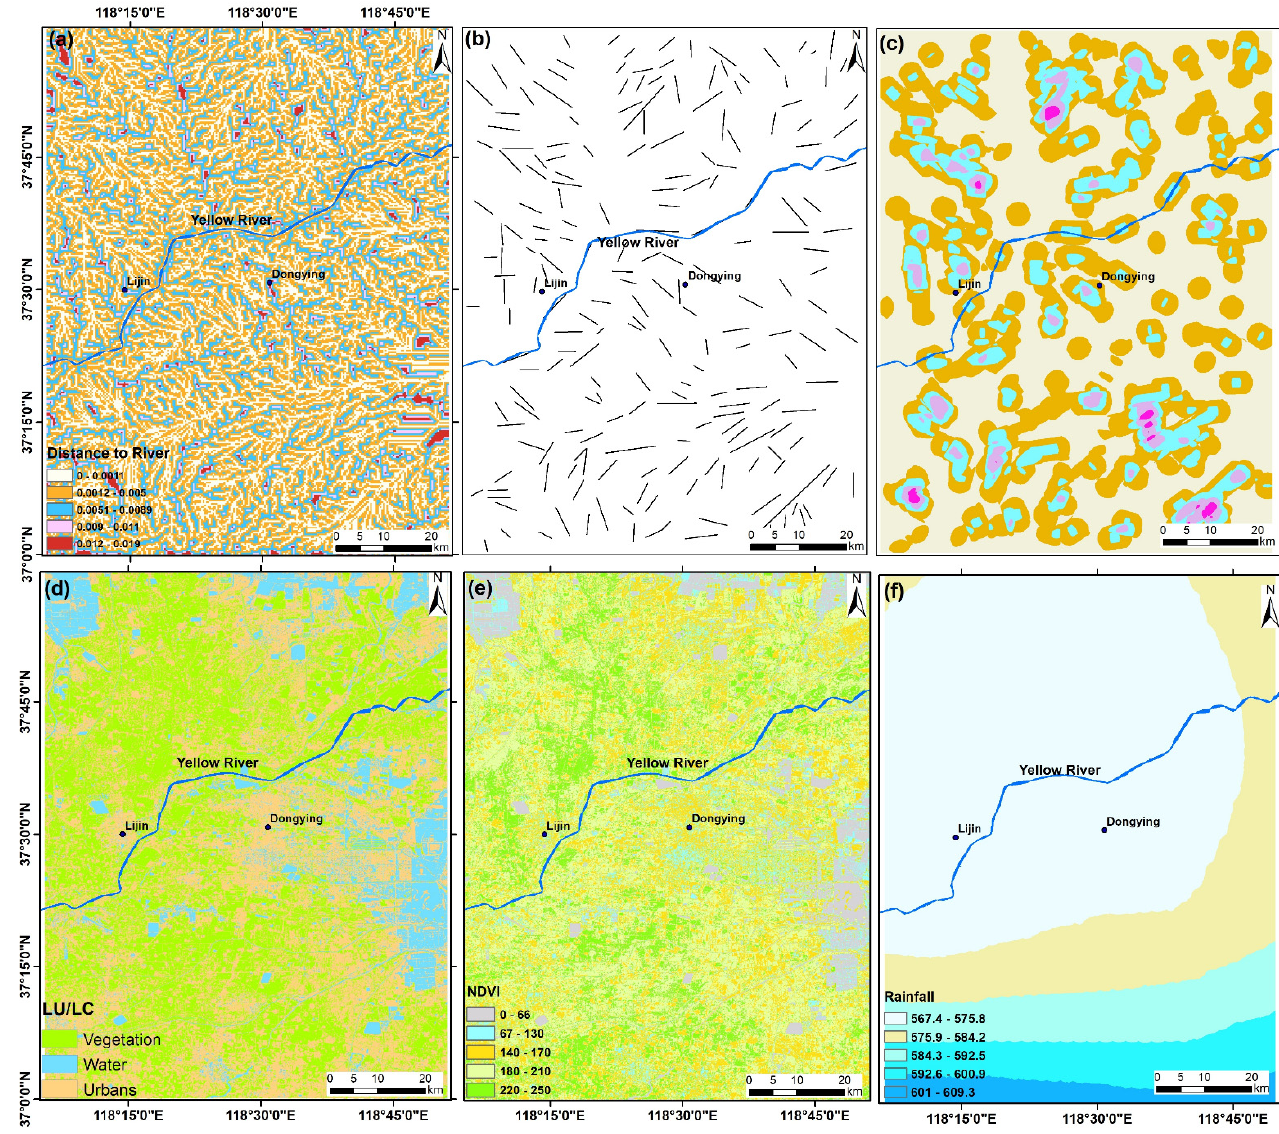
Figure 5. ( a ) Distance to rivers; ( b ) lineaments; ( c ) lineament density; ( d ) LC/LC; ( e ) NDVI; ( f ) rainfall